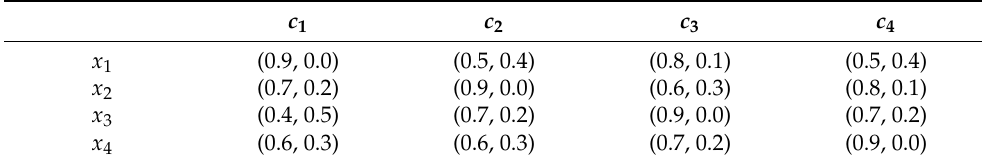
Table 4. The intuitionistic fuzzy decision matrix.